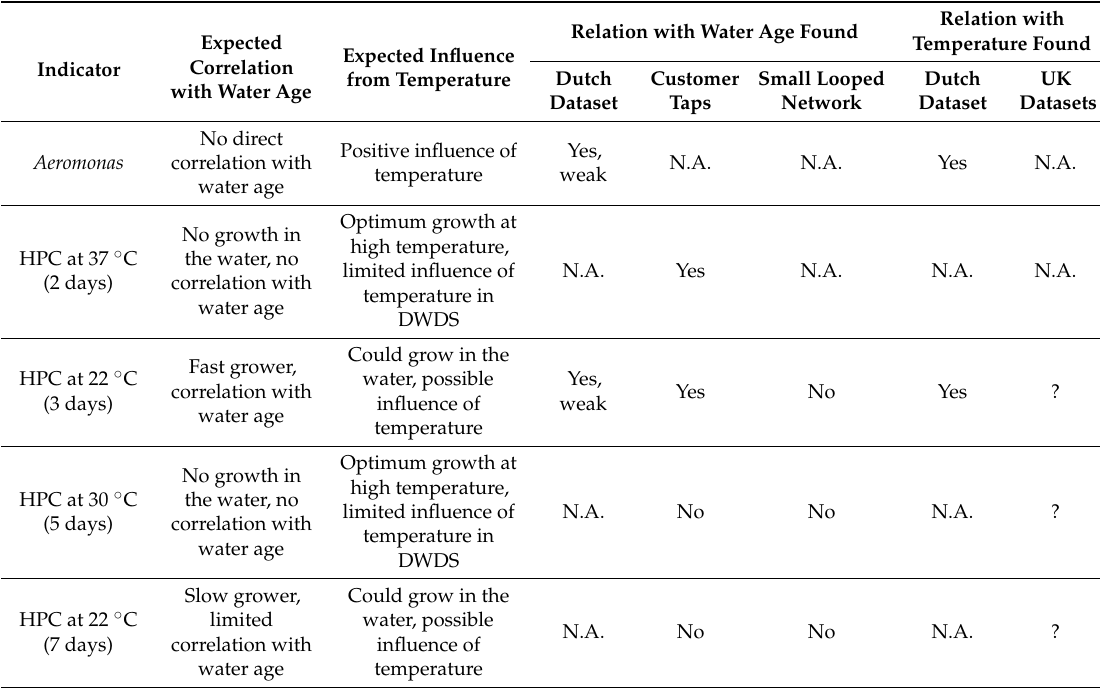
Table 5. Summary of correlations found between water age, temperature and microbial parameters for Dutch and UK